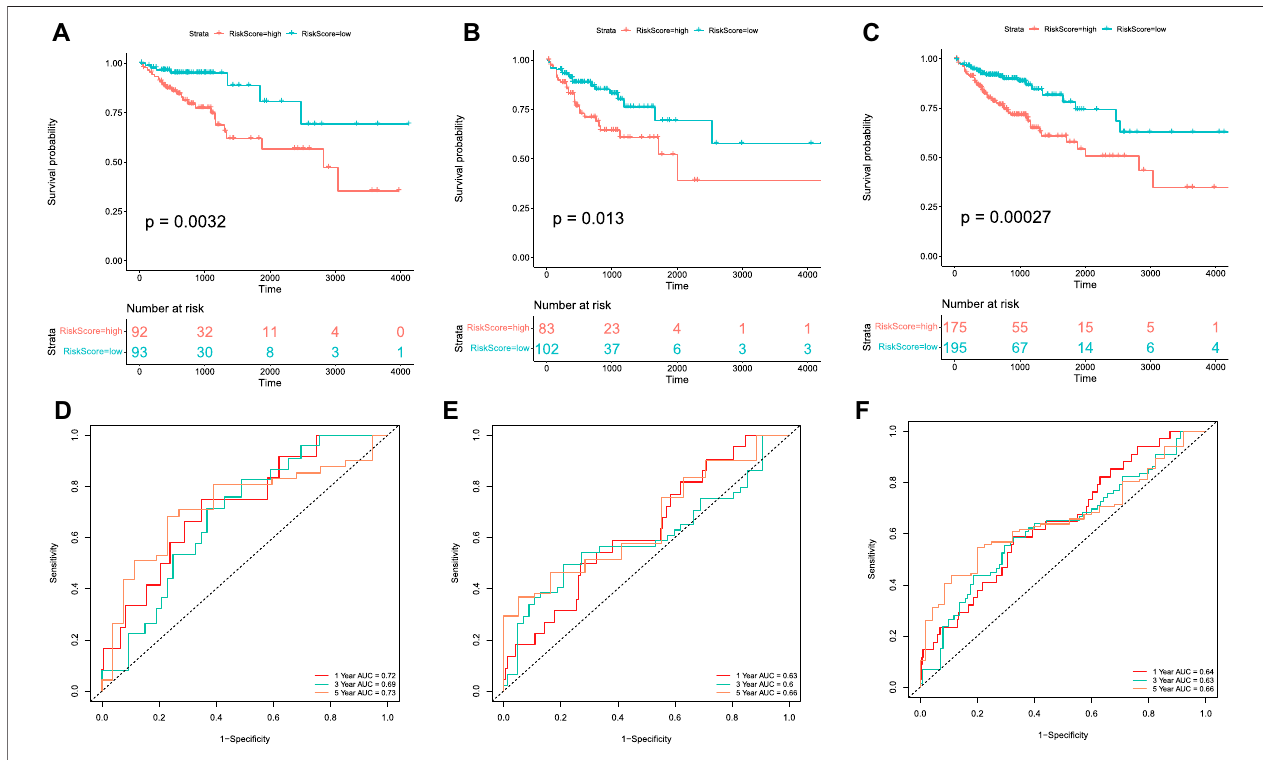
FIGURE5| Kaplan – MeiercurveandROCcurveofthemodelinTCGA-COAD. Kaplan – MeiercurvesoftheOSofpatientsbetweenhigh-riskandlow-riskgroupsin the training set (A) , test set (B) , and whole set (C) . Time-dependent ROC curve analysis of the RS in the training set (D) , test set (E) , and whole set (F) .